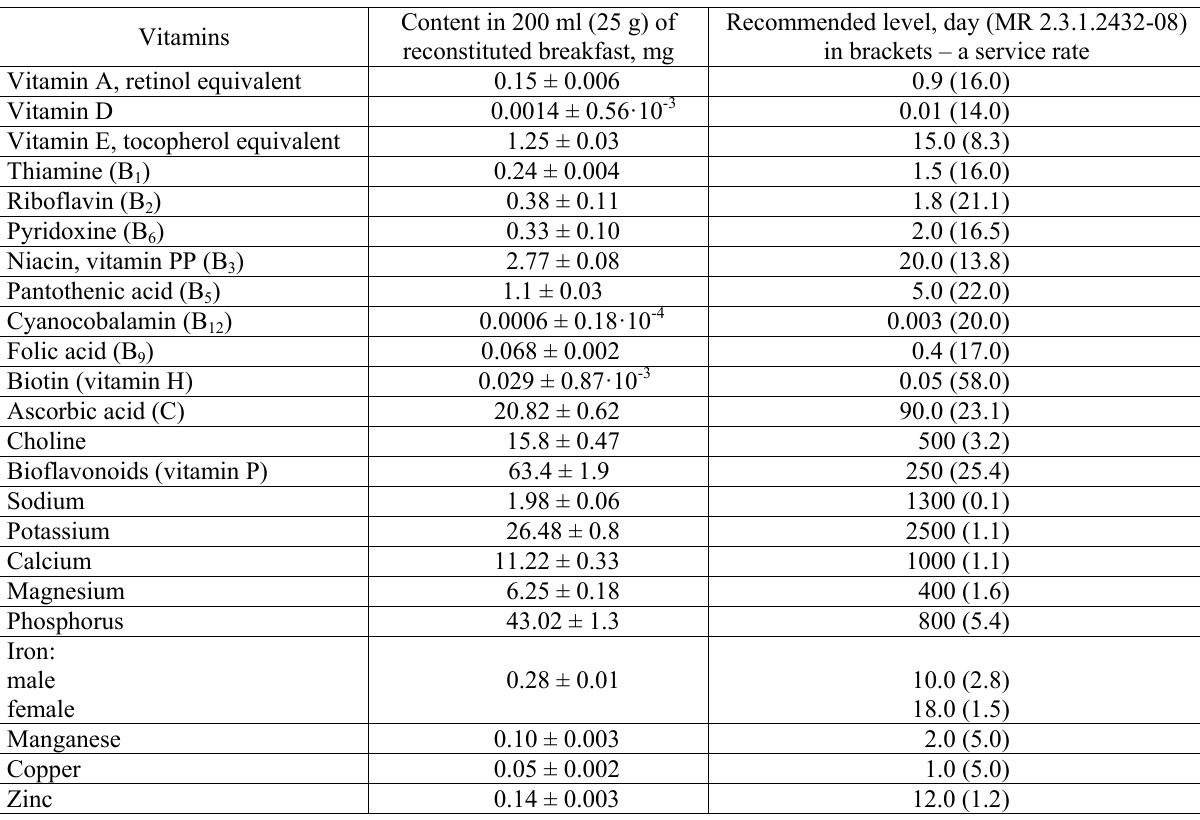
1 Table 4. Nutritional value of granular